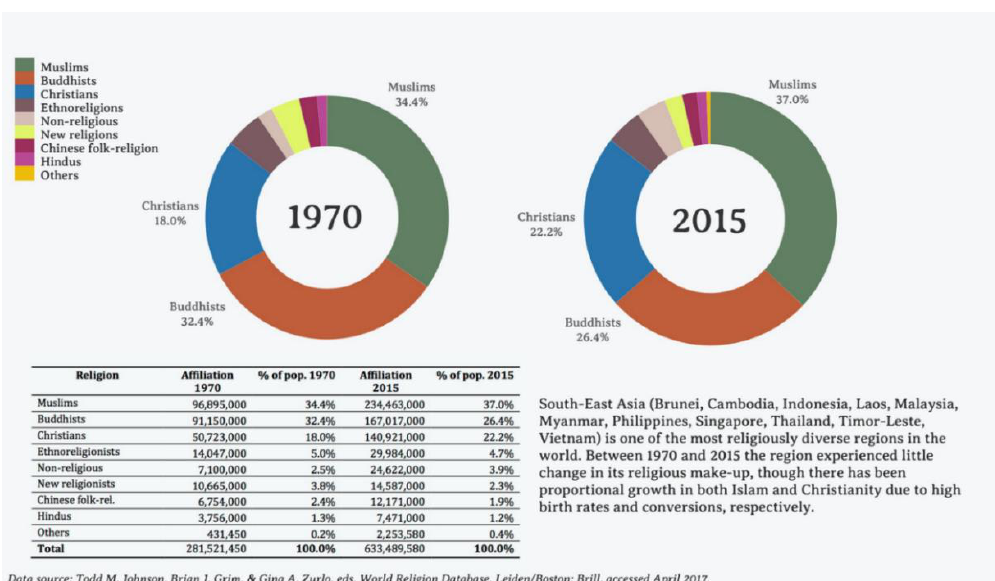
Figure 3. The growth of religion in China, 1970 and 2015.